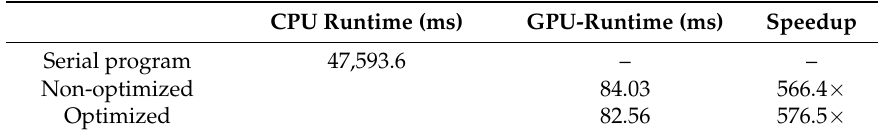
Table 3. Runtime and speedup for the GPU ‐ based SDCSM program with constant memory access optimization.